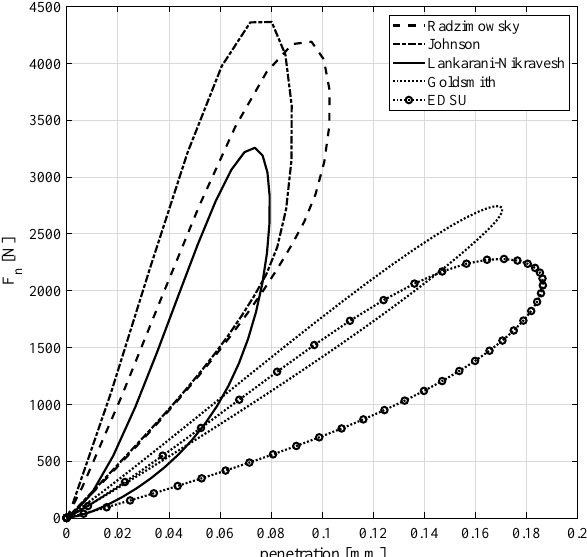
Figure 15. Hysteresis comparison.